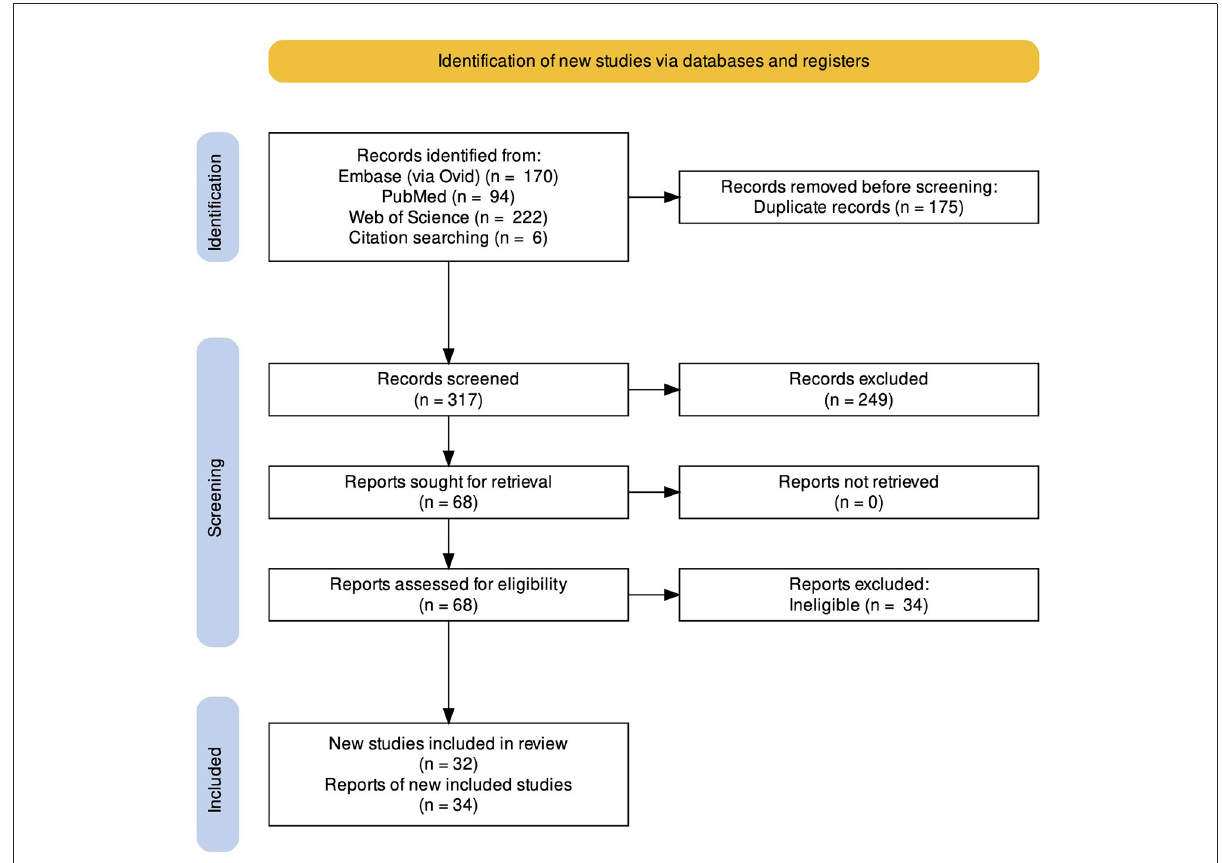
FIGURE1 PRISMA Flow diagram of the study. We identified 486 records through database searching and six records through citation searching. Following deduplication, 317 records were screened, from which, 32 relevant studies (34 reports) were found and included in the review.